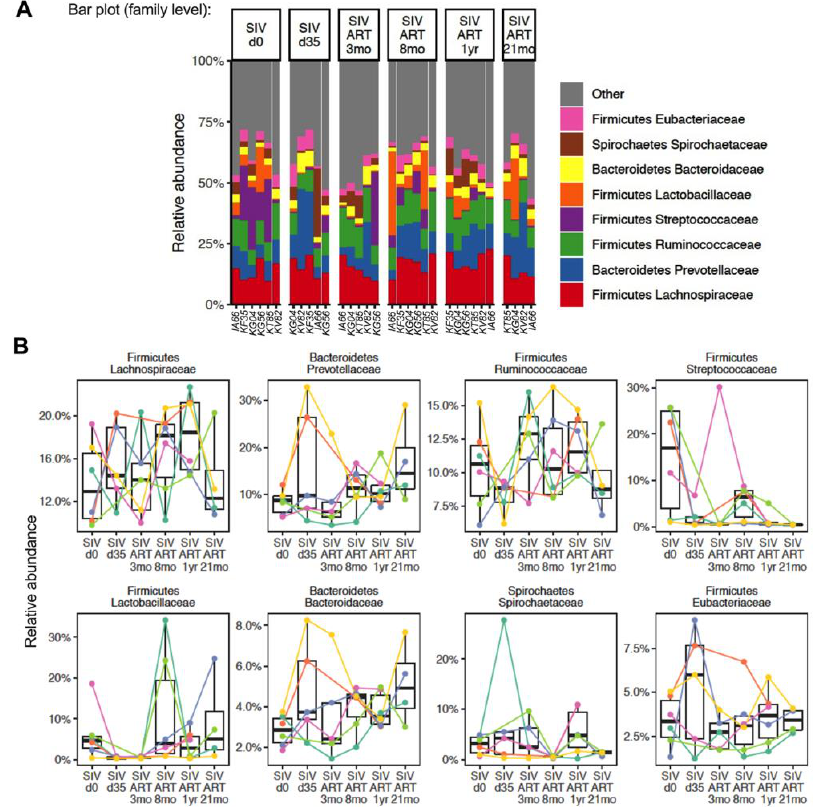
Figure 2. The composition of gut bacterial communities at the family level. ( A ) Relative abundance of fecal bacterial taxa at the family level in each animal at baseline (d0), d35 post-SIV infection, and at 3 mo, 8 mo, 12 mo, and 21 mo ART time-points. ( B ) Longitudinal changes in relative abundance in individual animals at the indicated time-points. IA66 and KT85; KF35 and KG56; KG04 and KV82 were pair-housed to enable social